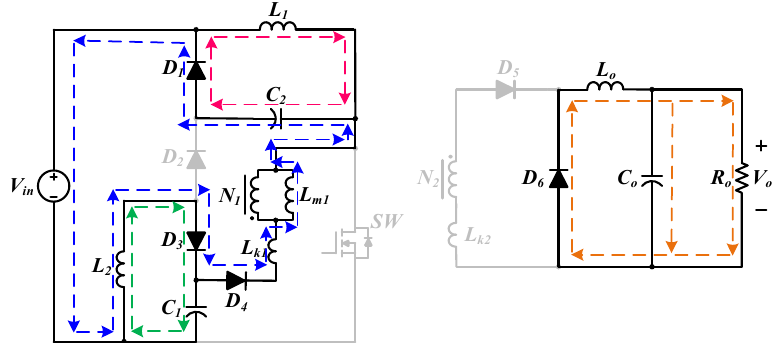
Figure 8. Equivalent circuit of the CHSDC in Mode 3.